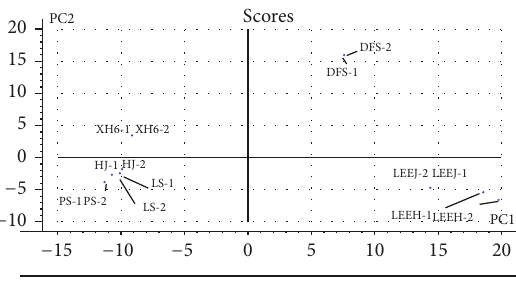
Figure 4: PCA scores derived using the average concentration of volatiles detected by GC-MS in different SFFPs samples.